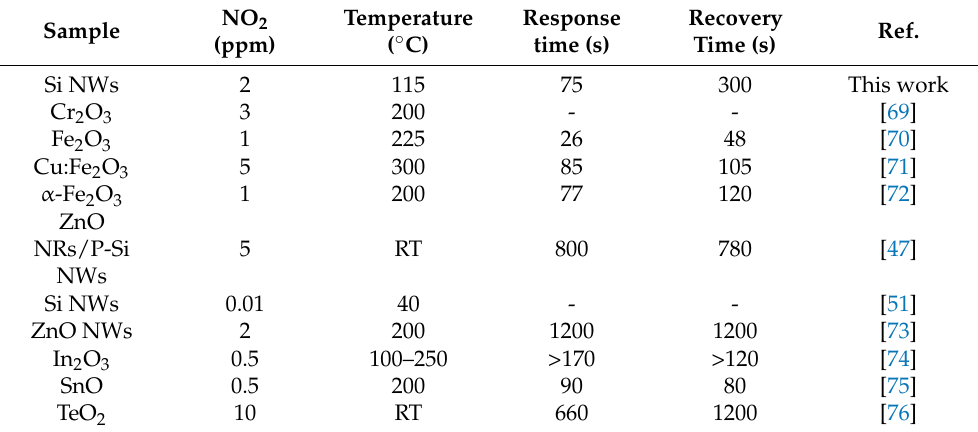
Table 1. Comparison of NO 2 sensing properties of our Si NWs-based chemoresistive sensor with other